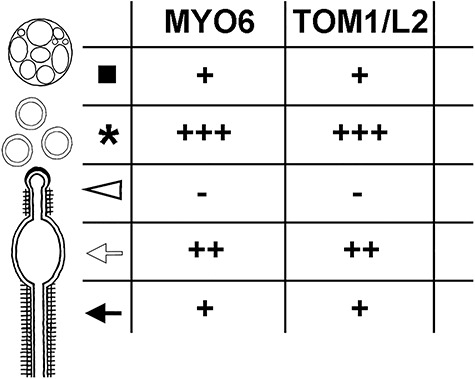
MYO6 and TOM1/L2 localize mainly to TBC bulbs prior and shortly after their internalization. The number of gold particles showing the localization of MYO6 or TOM1/L2 in different sub-compartments of TBCs on all acquired images scored as follows: + ≤ 10 gold particles, ++ ≤ 100 gold particles, +++ > 100 gold particles.